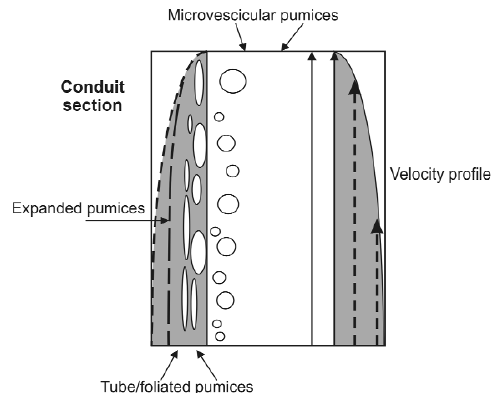
Fig. 2. Zonation of different pumice types within the volcanic conduit, after Polacci et al . (2003). Not to